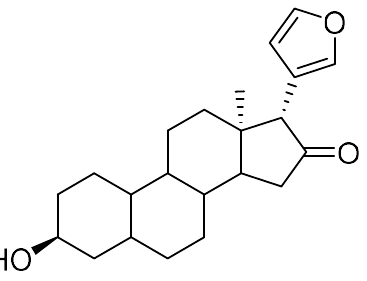
Figure 9. The characteristic structure of limonoids metabolites with antifeedant and toxic effects.